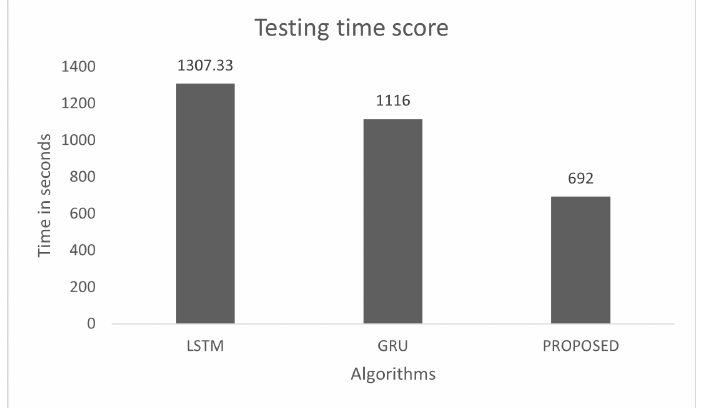
Figure 13. Testing Time on the combined DDoS